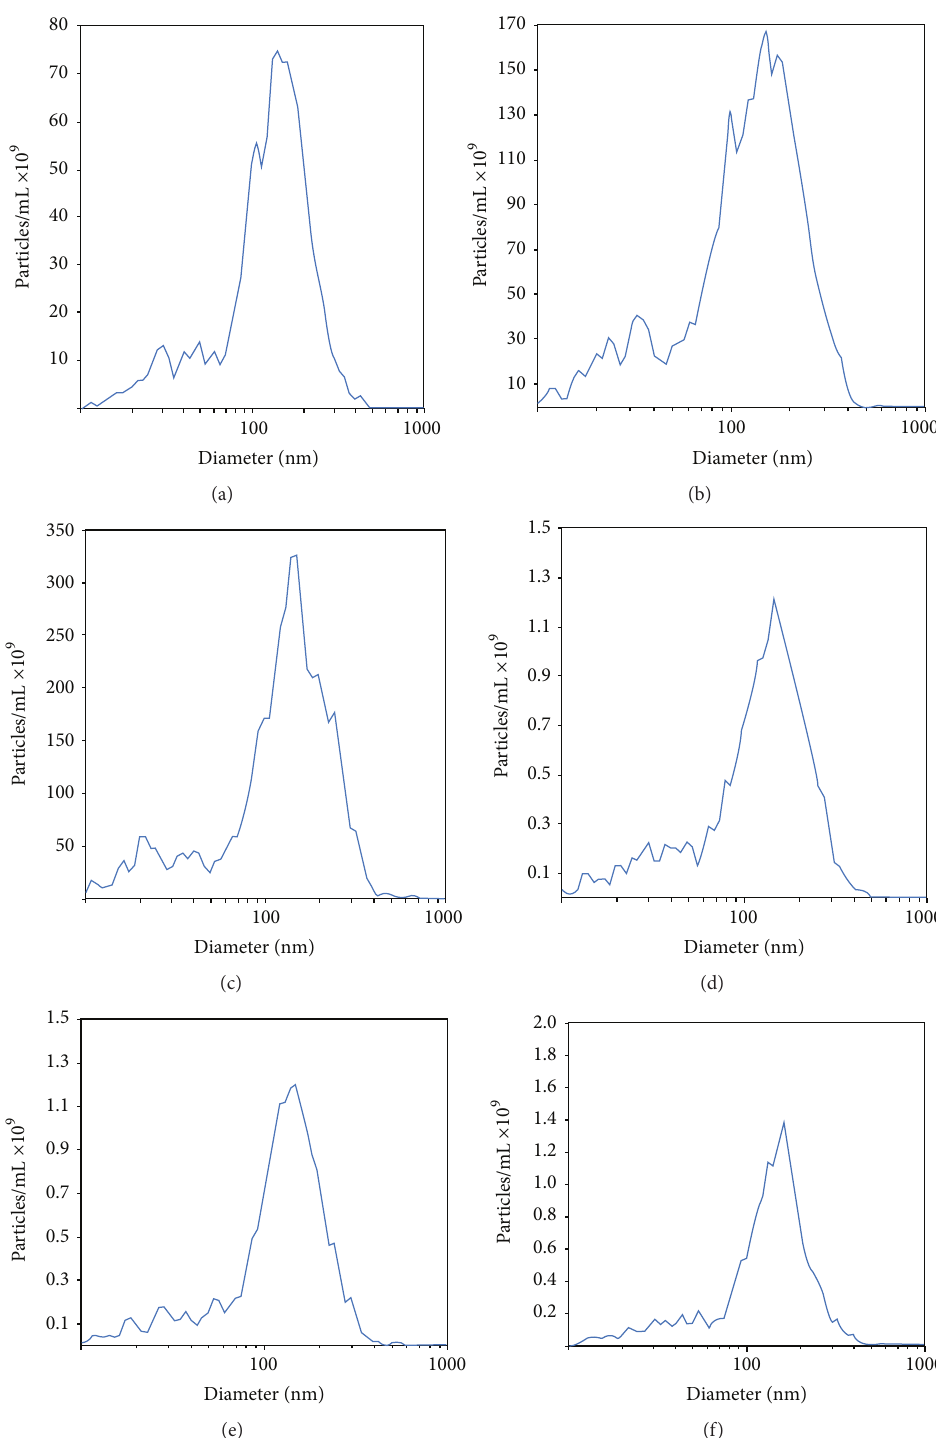
Figure 3: Nanoparticle Tracking Analysis (NTA) of microvesicles purified from serum of patients with active synovial sarcoma ((a)–(c)) and synovial sarcoma cells ((d)–(f)). Mean diameter peaks were 151.7 nm for microvesicles extracted from synovial sarcoma patient serum ((a)– (c)) and 154.4 nm ((d)–(f)) for microvesicles purified from synovial sarcoma cells. Mean concentration levels were 3155.0 × 10 9 particles/mL in serum of patients with active synovial sarcoma ((a)–(c)) and 18.60 × 10 9 particles/mL in synovial sarcoma cell supernatant